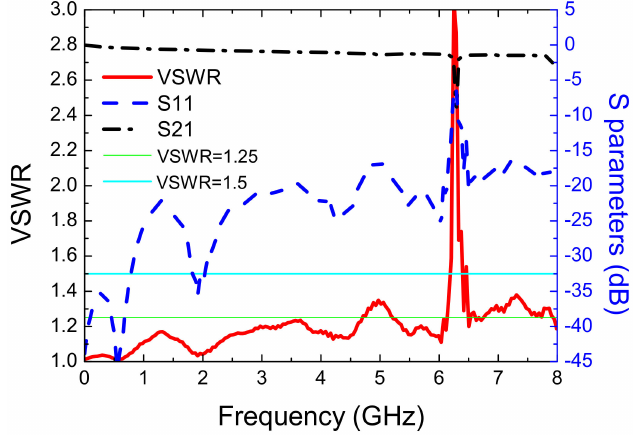
Figure 3. S-parameters and VSWR measurement results of the cell (Size 2 in Table 1).